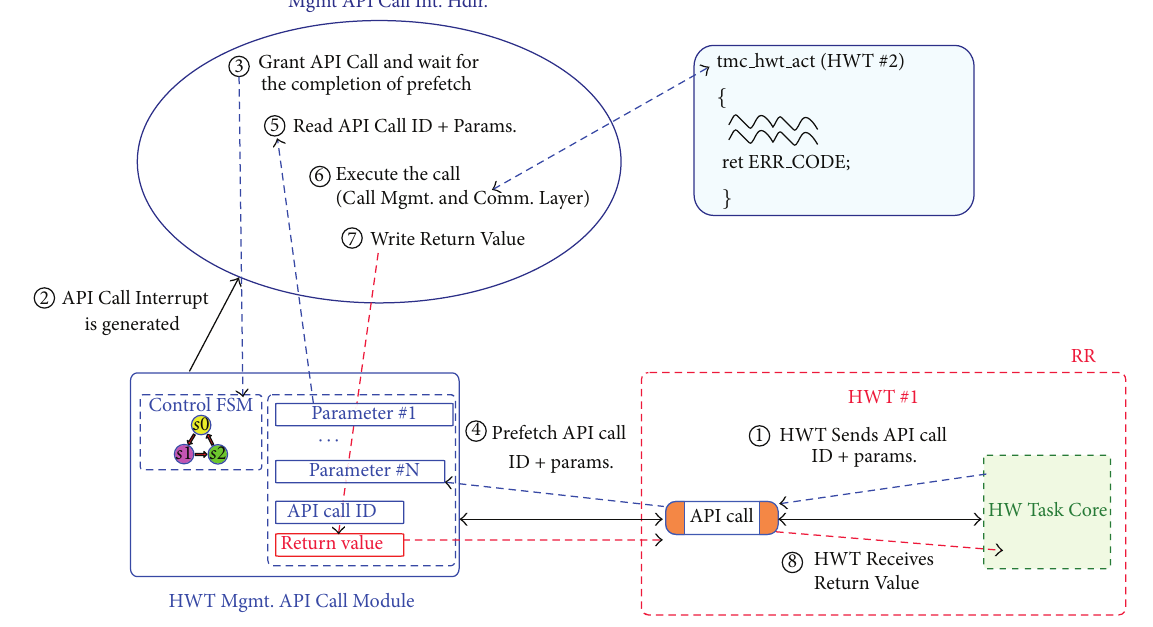
Figure 11: Processing of Task Management API Call by an HWT caller.